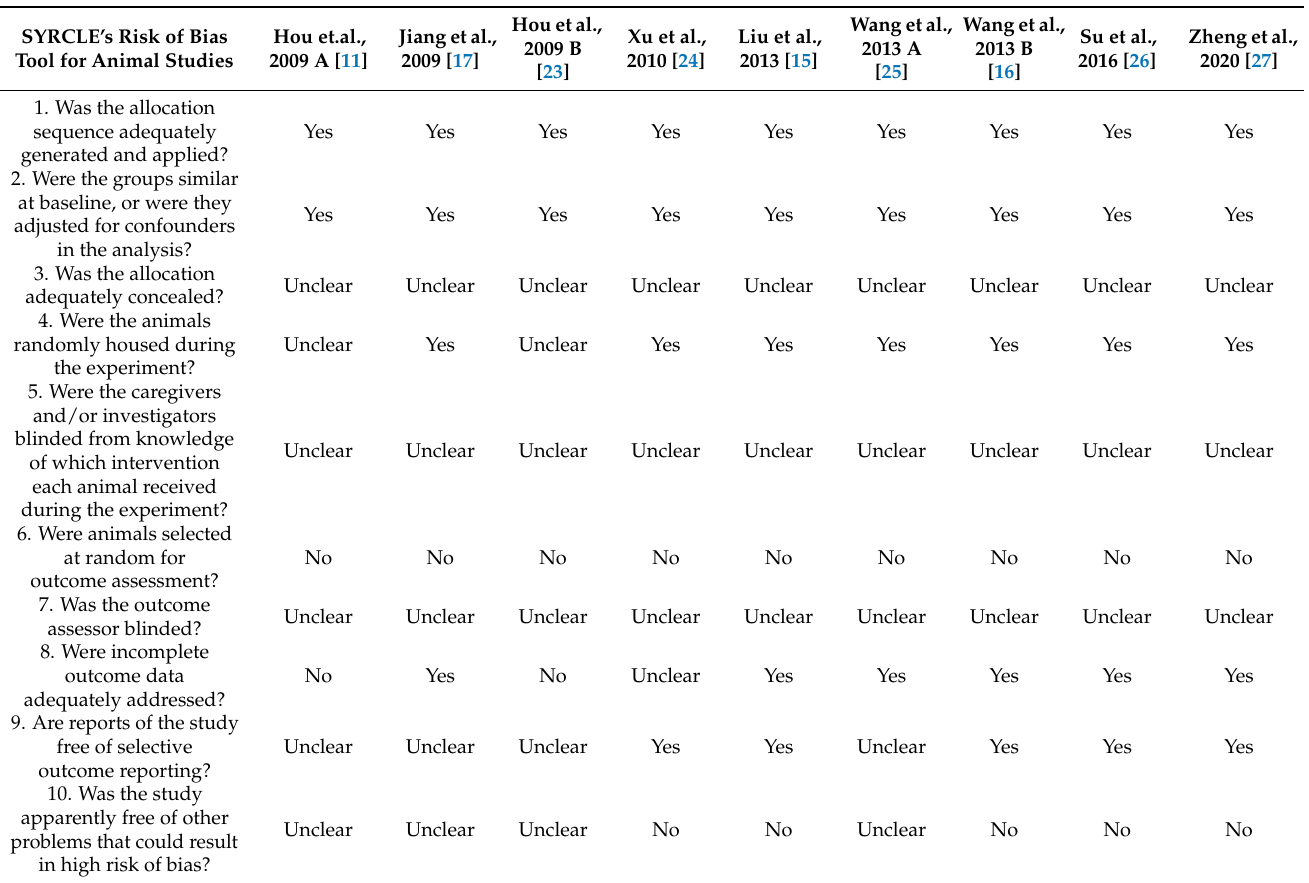
Table 2. SYRCLE’s Risk-of-Bias